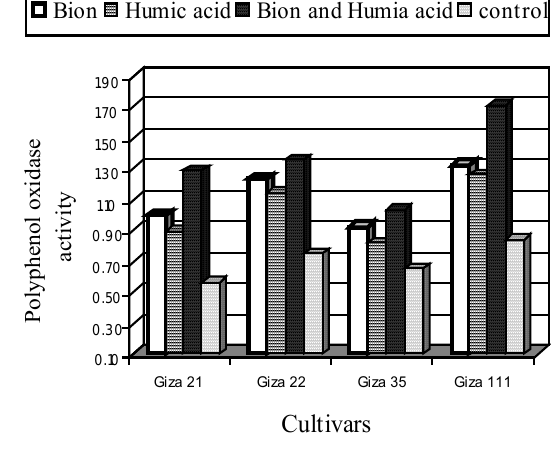
Fig. 1. Activity of peroxidase enzyme (enzyme unit mg protein -1 min -1 ) of four soybean cultivars as affected by BHT (0.5 g/l), HA (4 g/l) individually or combination (0.25+4 g/l)